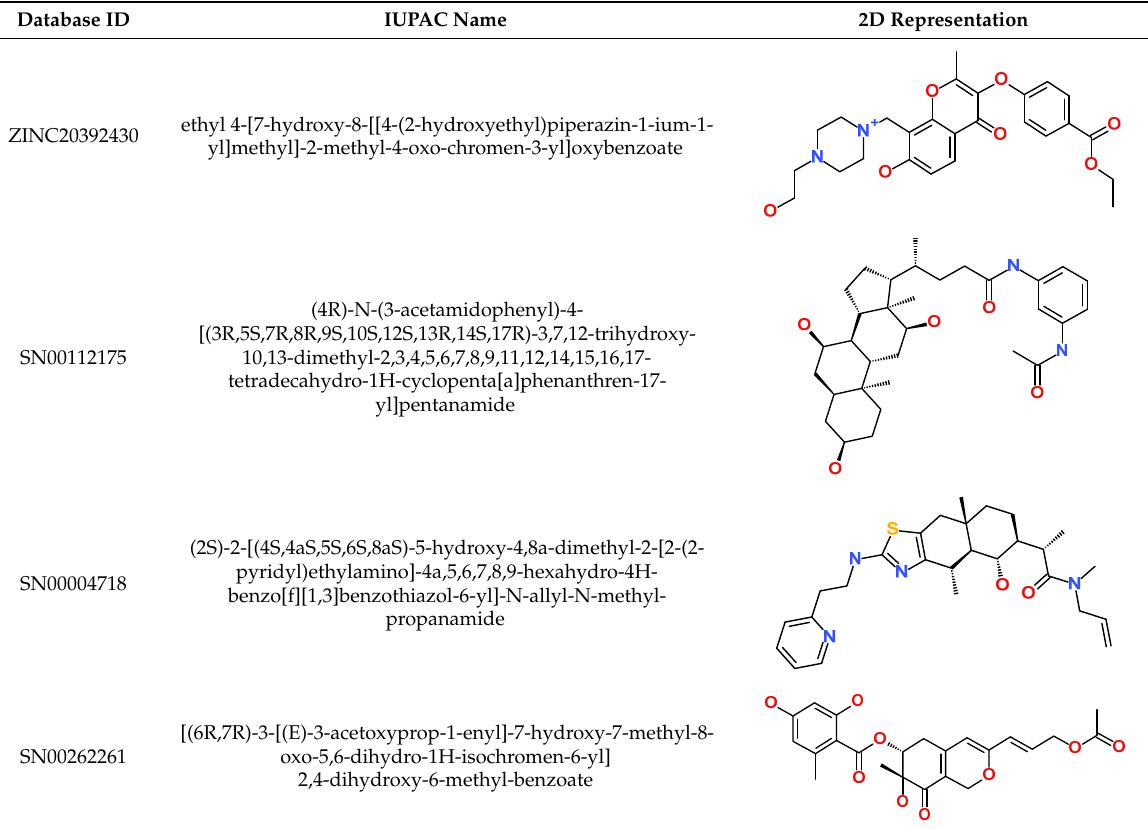
Table 6. The database ID, IUPAC name, and 2D representation of the final identified hits.